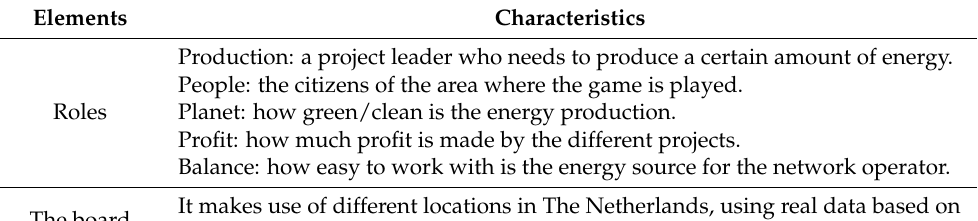
Table 1. We-Energy Game characteristics. Elements